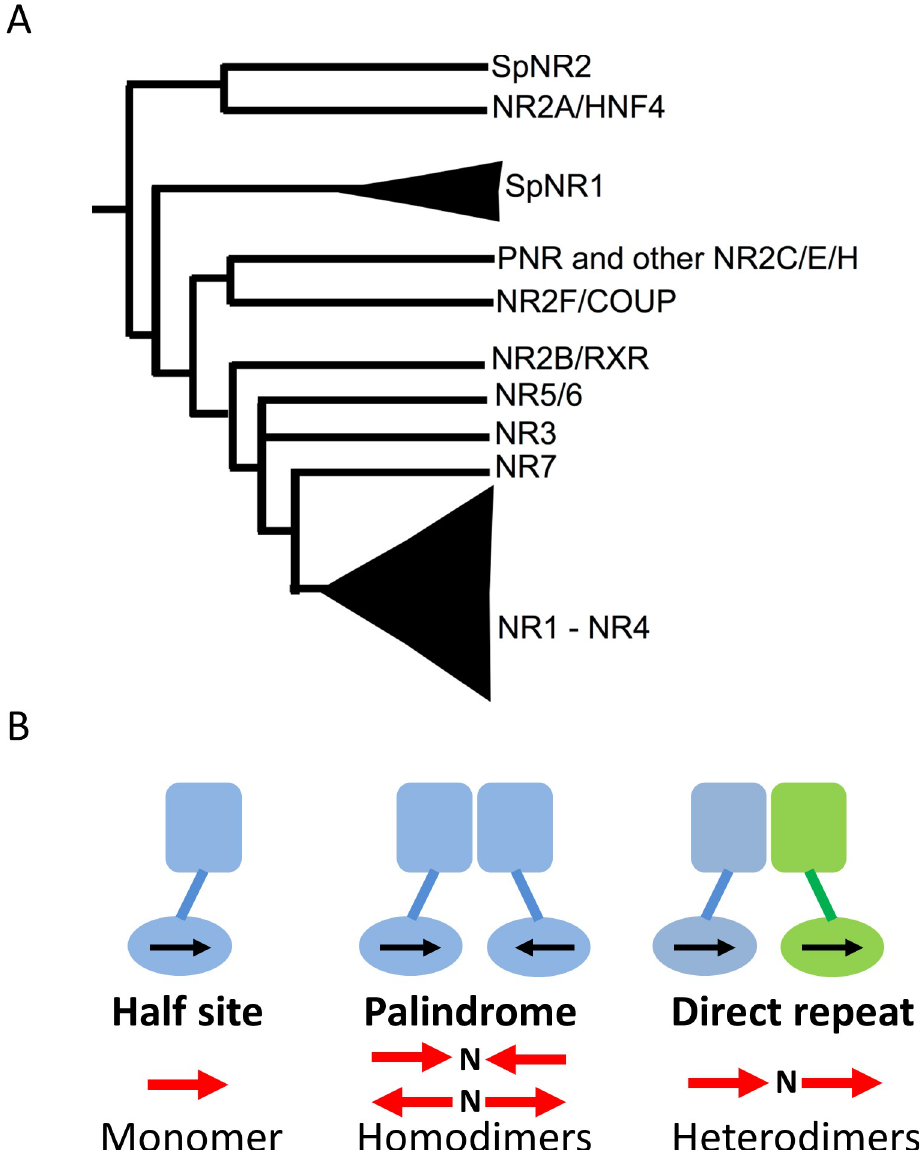
Fig 1. (A) Simplified consensus tree of NR phylogeny based on Bridgham et al., 2010 [9]. (B) Some of the diversity found for the different DNA response elements (REs), illustrated here with a monomeric NR on an (extended) half- site; a homodimer on an inverted or an everted RE; and finally a heterodimer on direct repeat RE; N is the number of base pairs in the spacer between the two